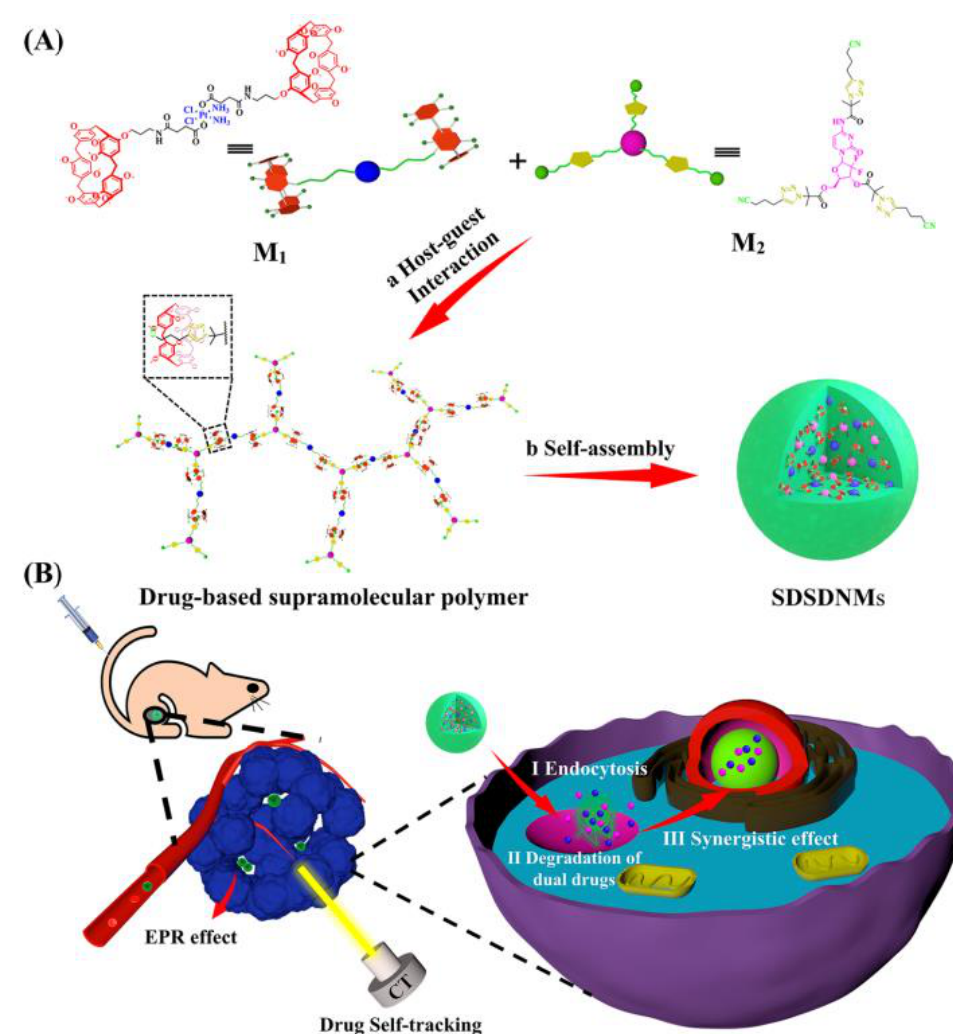
Figure 9. Schematic representation of the SDSDNMs developed by Liu et al. [141]. ( A ) Construction process. ( B ) Accumulation at the tumor site. Reproduced with permission from [141], American Chemical Society, 2021.